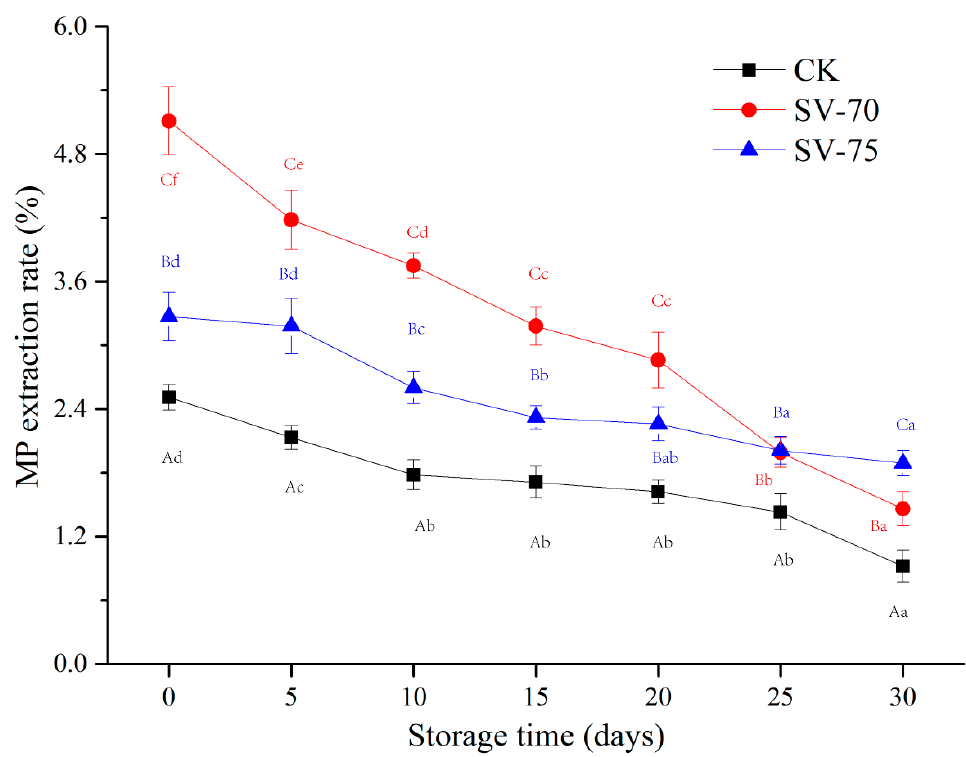
Figure 2. Changes in the MP extraction rate of scallop muscle with different treatments during 30 d of chilled storage. Different lowercase letters in the same color for the same point plot indicate significant difference ( p < 0.05), and different uppercase letters in the same storage time indicate significant difference ( p < 0.05).